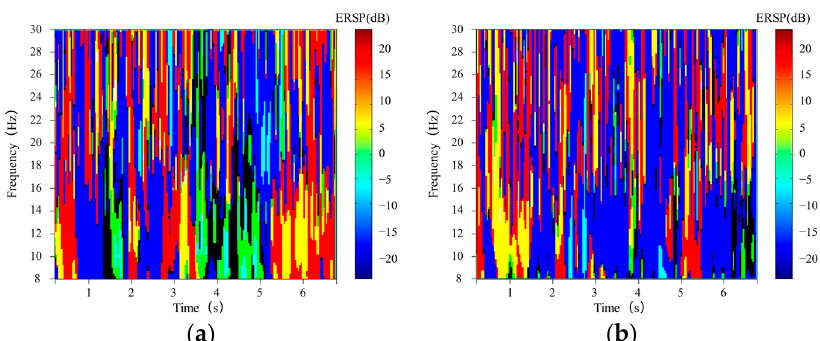
Figure 4. Final combined time-frequency images of left-hand ( a ) and right-hand ( b ) motor imagery. It can be seen that the energy difference between the two time-frequency images is obvious 4 s after the trail begins.